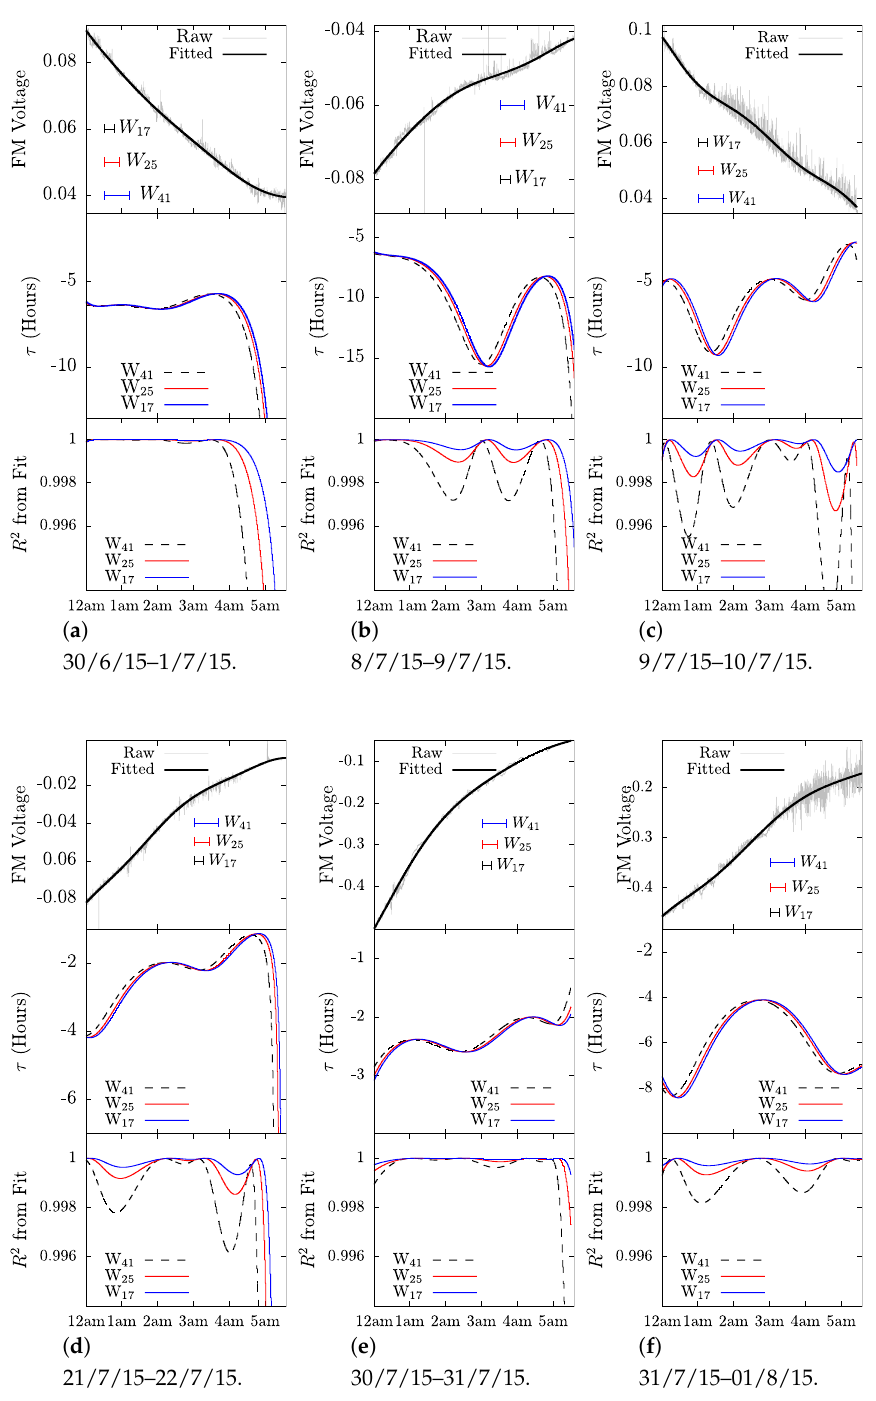
Figure 10. Field Mill Voltage, Instantaneous time constant ( τ ) and the calculated R 2 from each fit for the three window lengths (41, 24 and 17